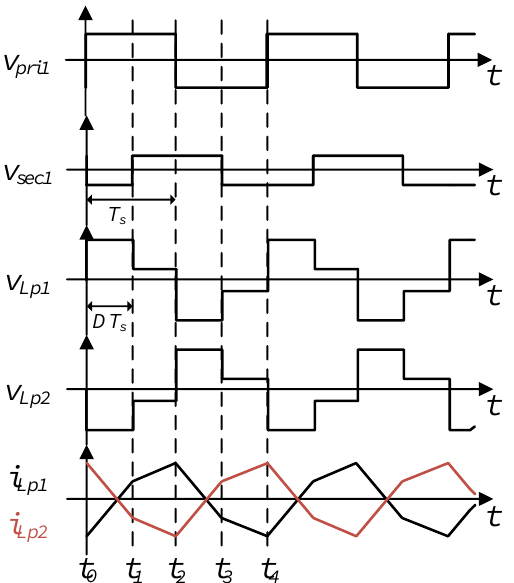
Figure 4. Key waveforms of the HBDAB converter.